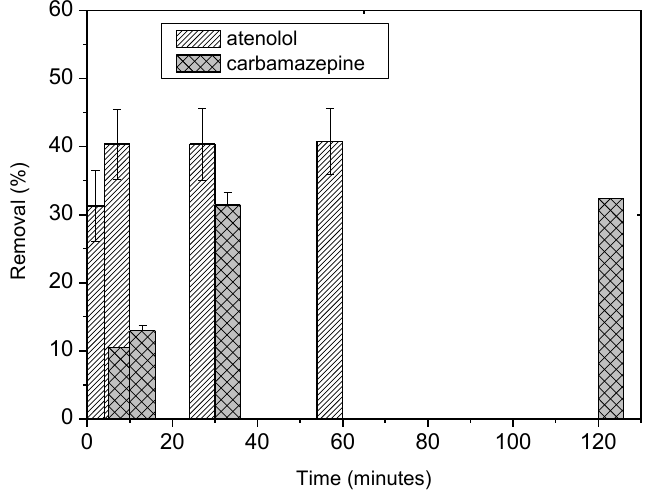
Table 4. Langmuir and Freundlich model parameters calculated by linear fitting of the adsorption